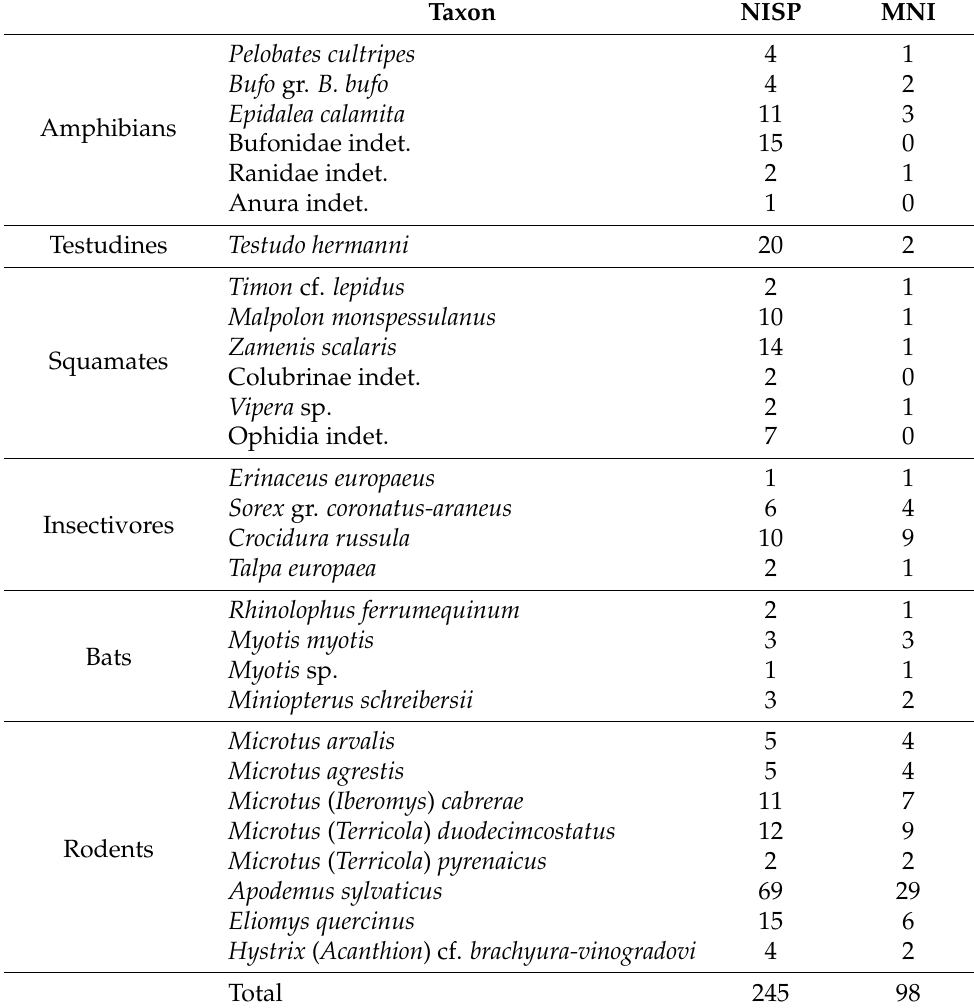
Table 5. Number of Identified Specimens (NISP) and Minimum Number of Individual (MNI) of the small vertebrates identified at